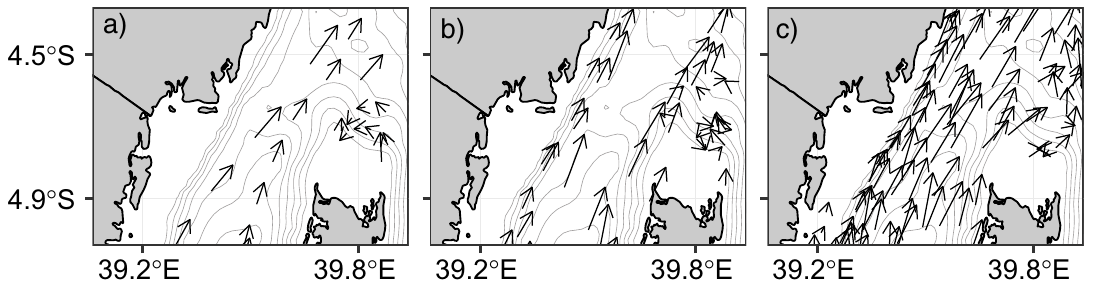
Fig 4. Vector field showing cyclic motion of current north of the Pemba Island during a) NE, b) IN and c) SE seasons. The gray isodepth represent hundred-meter interval contour lines.